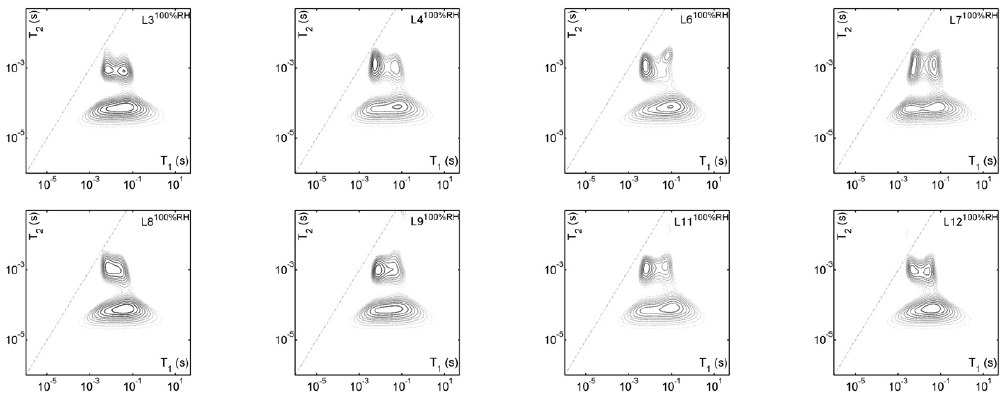
Figure 3. 2D 1H-NMR T 1 -T 2 maps of L 3- -, L 4 -, L 6 -, L 7 -, L 8 -, L 9 -, L 11 - and L 12 -sections acquired at 100% RH. The graphic layout of the maps is the same as in Figure 2.